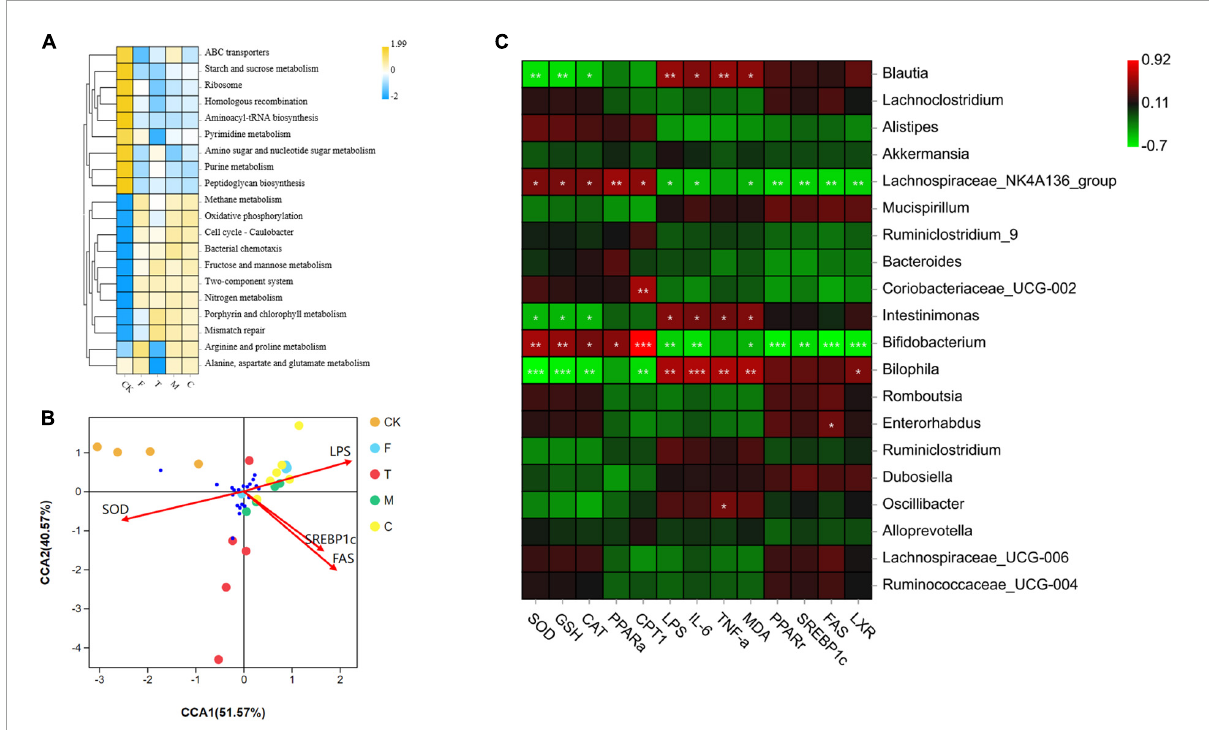
FIGURE7 (A) Comparison of bacterial functions predicted by Tax4Fun among groups. (B) Canonical correspondence analysis (CCA) analysis of between the cecal microbiota and environmental factors. (C) Heatmap of Pearson correlation analysis between specific microbiota and obesity related indexes, including SOD, GSH, CAT, PPAR α , CPT1, LPS, IL-6, TNF- α , MDA, PPAR γ , SREBP1c, FAS, and LXR. The green color represented negative correlation, and red color represented positive correlation. A significant correlation is labeled by * p < 0.05, ** p < 0.01, *** p <